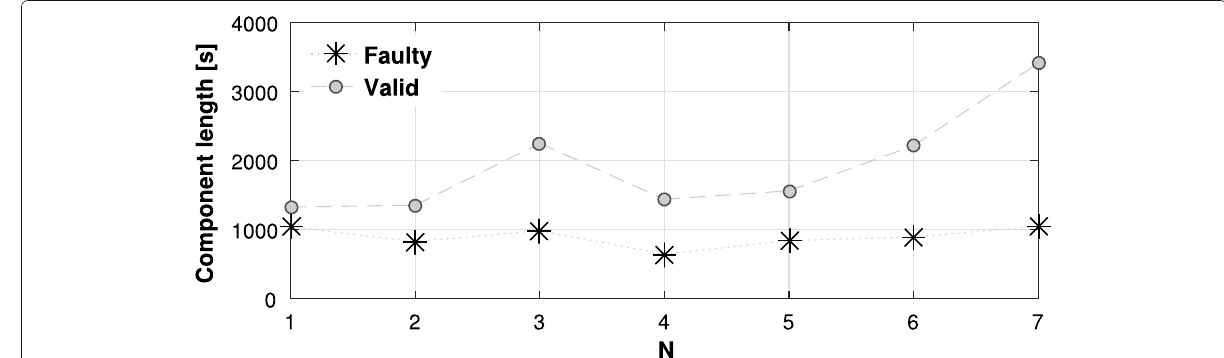
Fig. 12 The longest component length L max ( n ) in the spectrogram of faulty and valid electrodes for measured signals